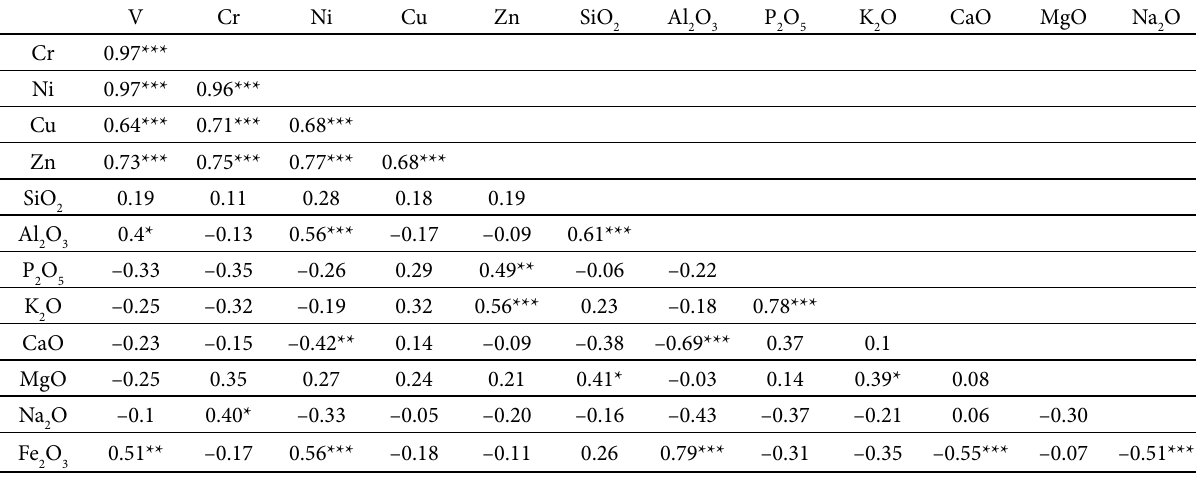
Table 9. Correlation coefficients between trace and major elements in soils of the study area